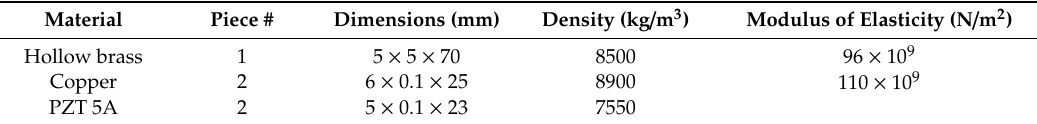
Table 2. Mechanical properties for the viscosity probe [35].